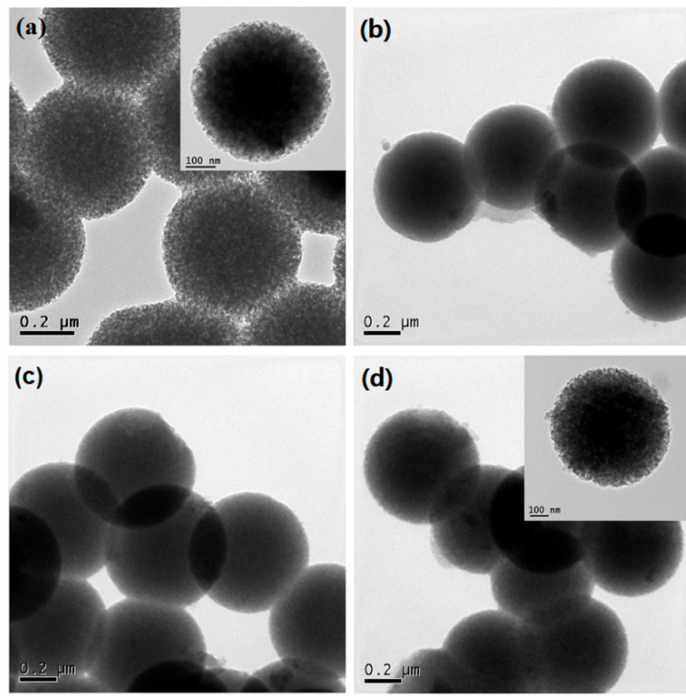
Figure 1. Transmission electron microscopy (TEM) images of 0 europium-containing mesoporous bioactive glass nanospheres (Eu/MBGs) ( a ), 0.5 Eu/MBGs ( b ), 1 Eu/MBGs ( c ) and 2 Eu/MBGs ( d ) (inset